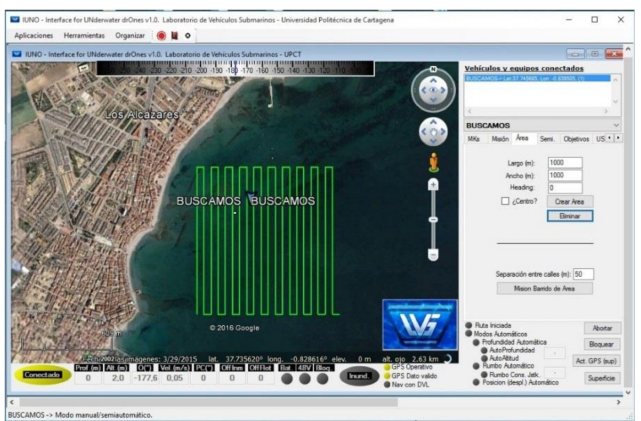
Figure 5. Graphical User Interface of IUNO software, showing exploration routes within a 1 km × 1 km box given by the four geographical coordinates (UTM) P1 (30T 690 4180), P2 (30T 690 4179), P7 (30T 691 4180) and P8 (30T 691